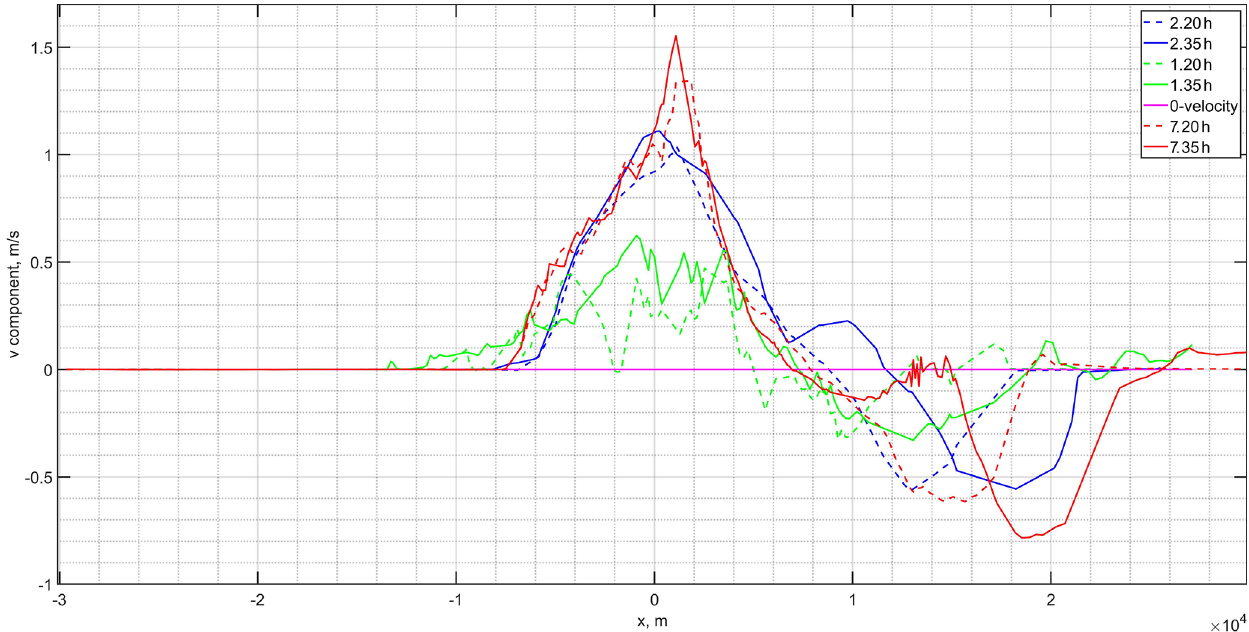
Figure 7. The surface v component of the horizontal velocity at the fixed y -axis position equal to the internal Rossby radius, ∼ 5 . 3km, for different runs at 20 and